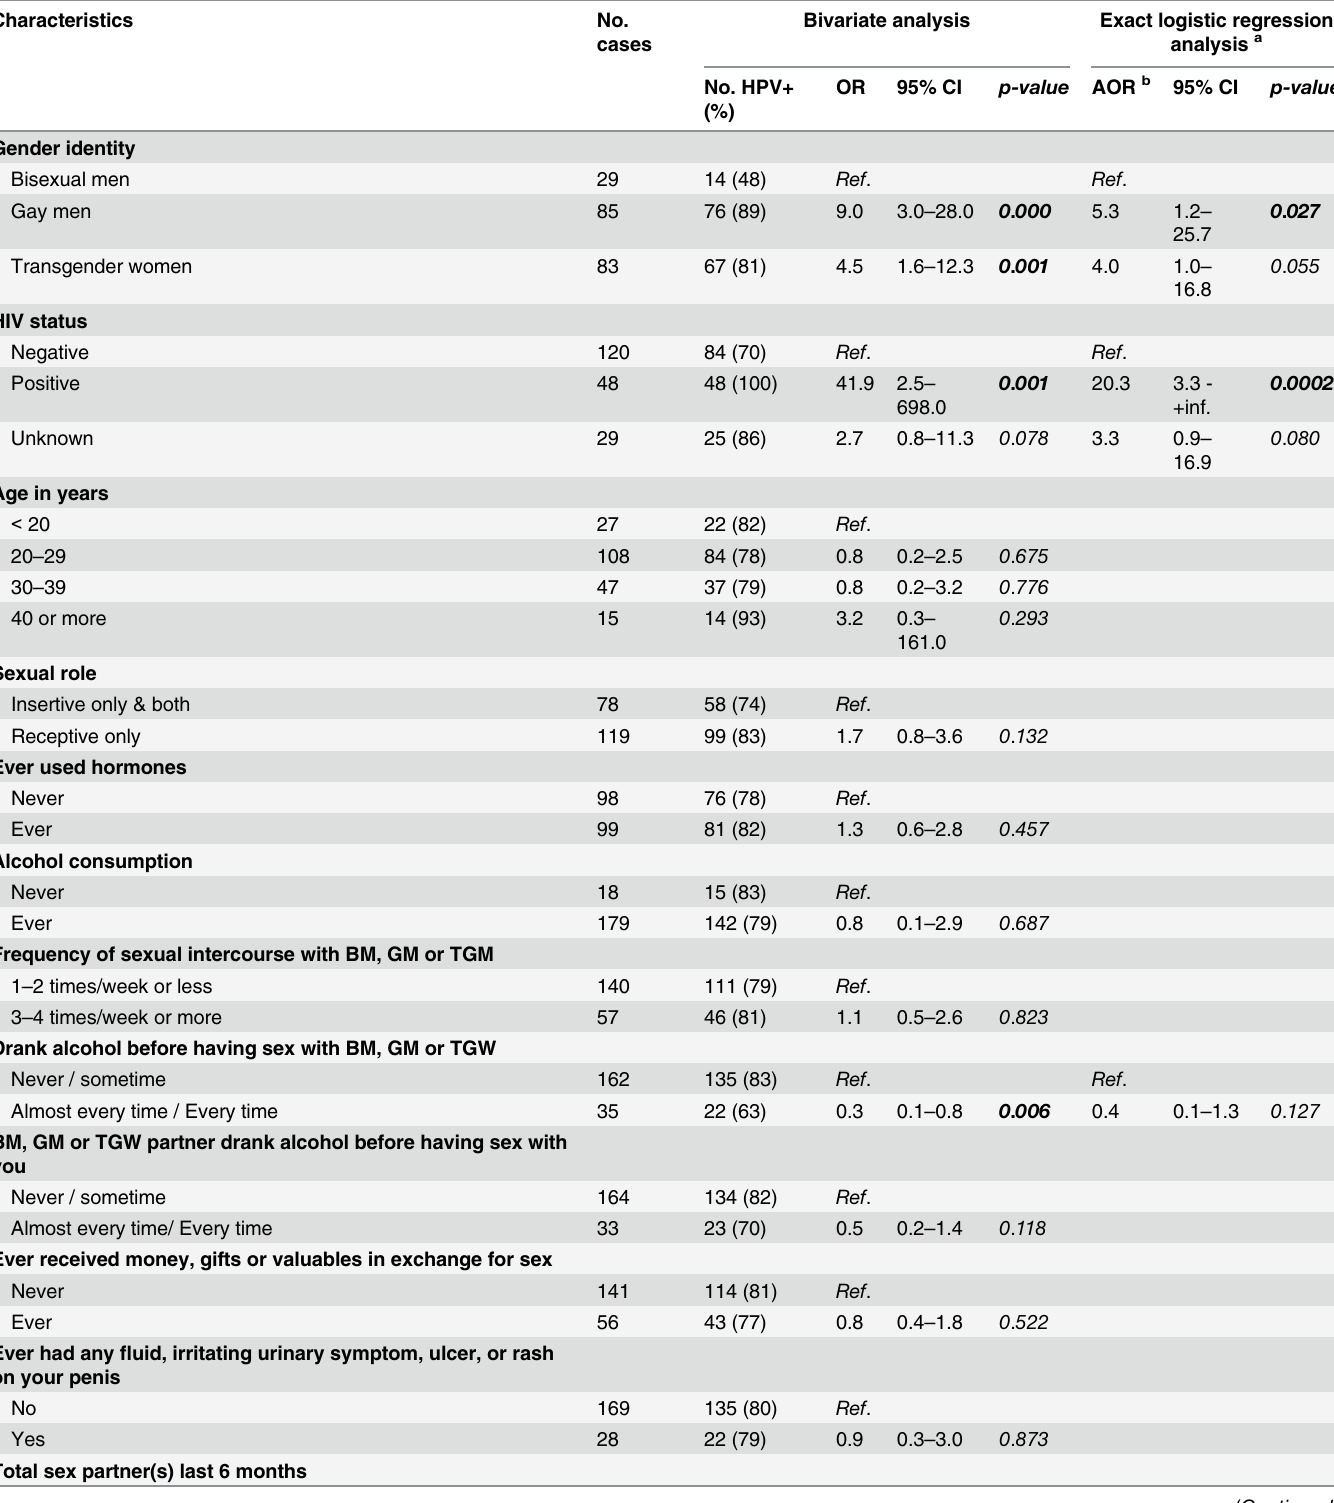
Table 6. Crude and adjusted Odds ratios by bivariate and exact logistic regression for any HPV positivity by demographic, behavioral, and sexual risk factors of MSM in Chiang Mai, Thailand.